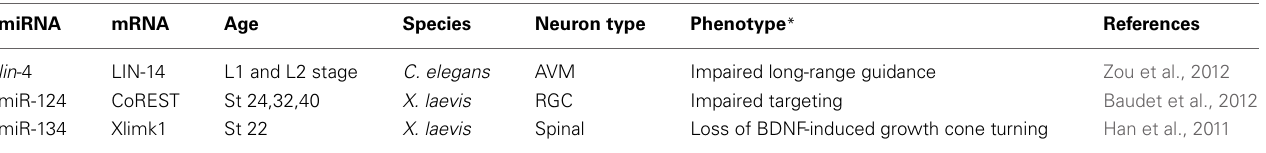
Table 1 | List miRNAs and their target involved in guidance.